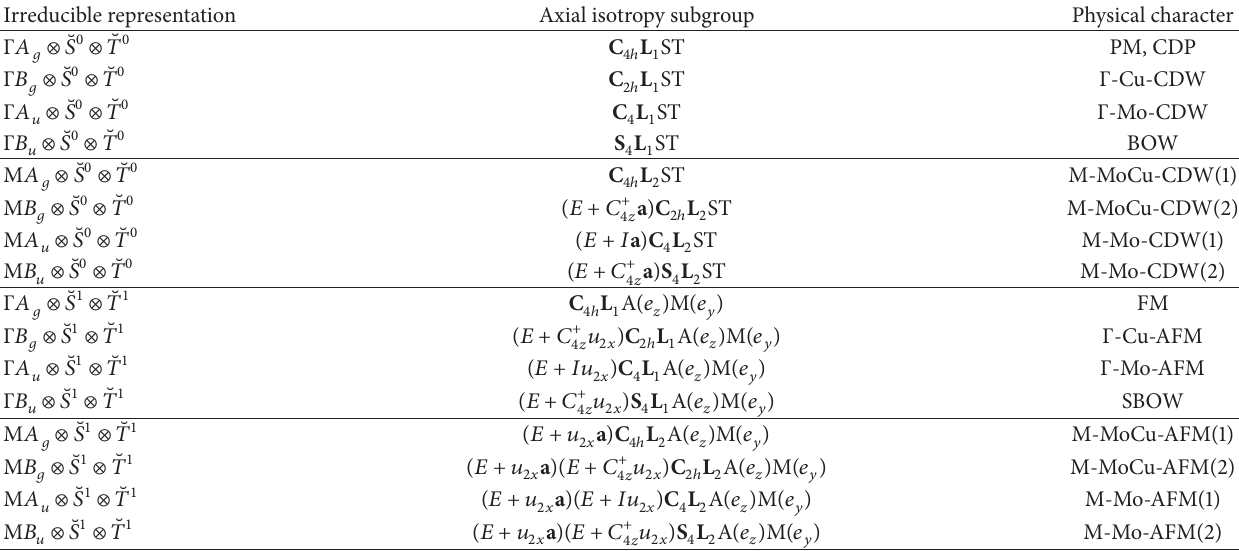
Table 1: Symmetry properties of the irreducible representations, Γ available in the Hamiltonian (1) subject to axial isotropy